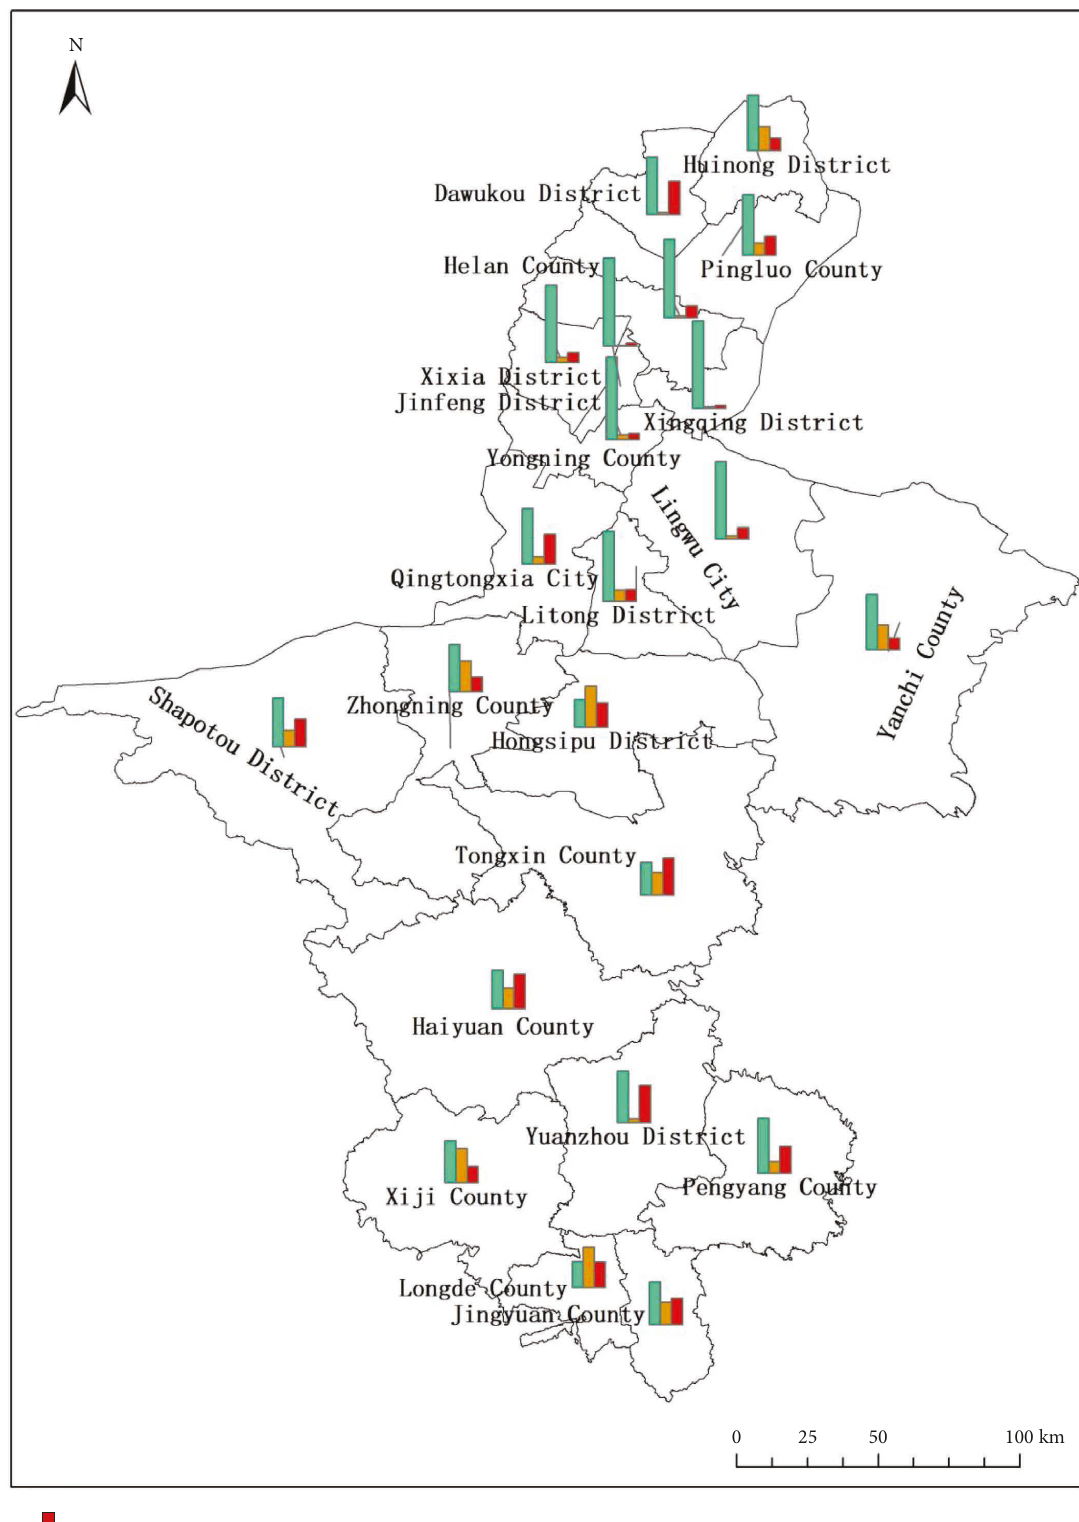
Figure 10: Proportions of the buildings in the three SP